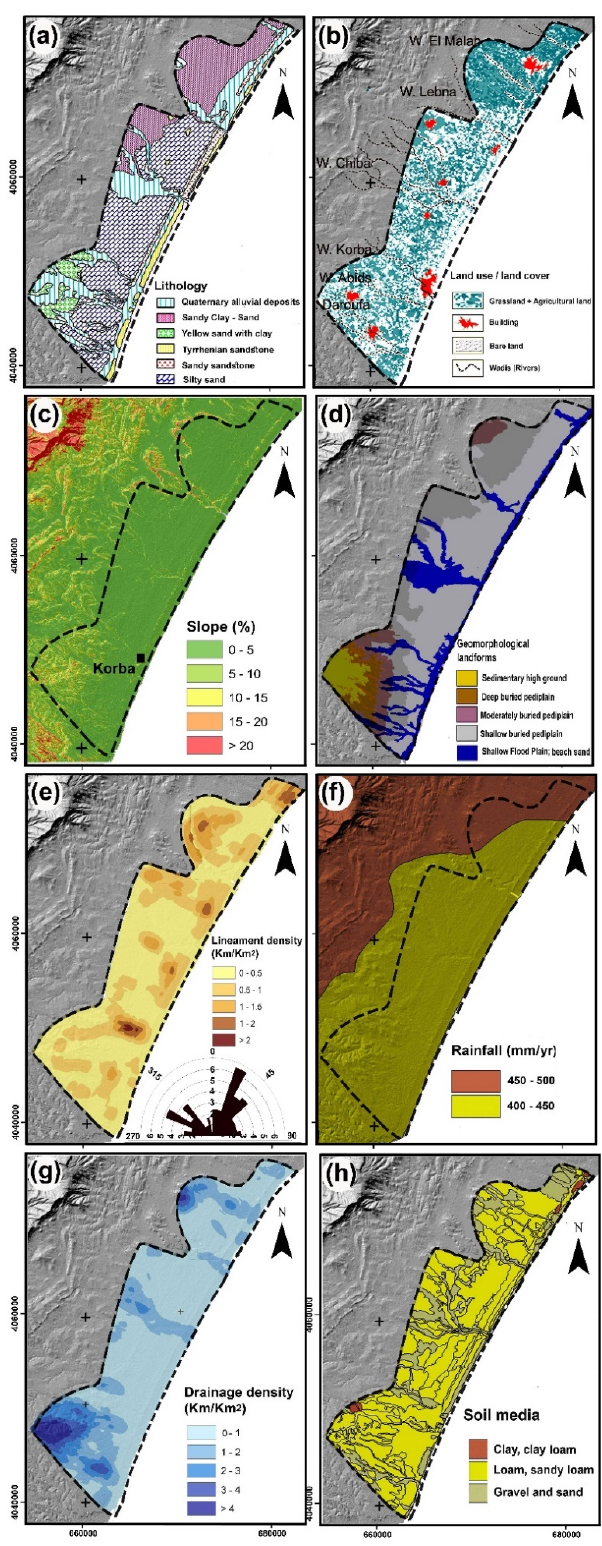
Figure 7. The eight thematic layers used in the multi-criteria decision making (MCDM) frameworks to map groundwater recharge potential: ( a ) Lithology, ( b ) Land use/Land cover, ( c ) Slope, ( d ) Geomorphology, ( e ) Lineament density map, ( f ) Rainfall, ( g ) Drainage density and ( h ) soil types.